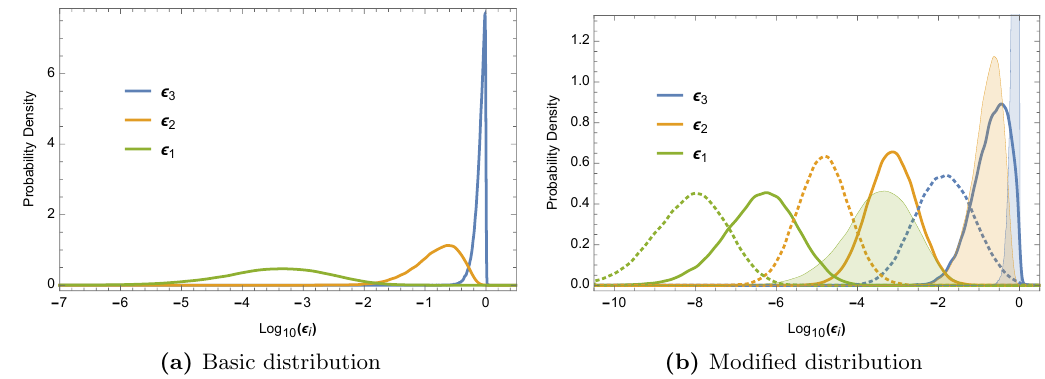
Figure 2. (a): distribution of eigenvalues of the matrix E with N = 10 clockwork gears. (b): modi(cid:12)ed distribution with (cid:24) = 2 (solid) and (cid:24) = 3 (dashed), see text for details. For comparison we show again the unmodi(cid:12)ed distribution